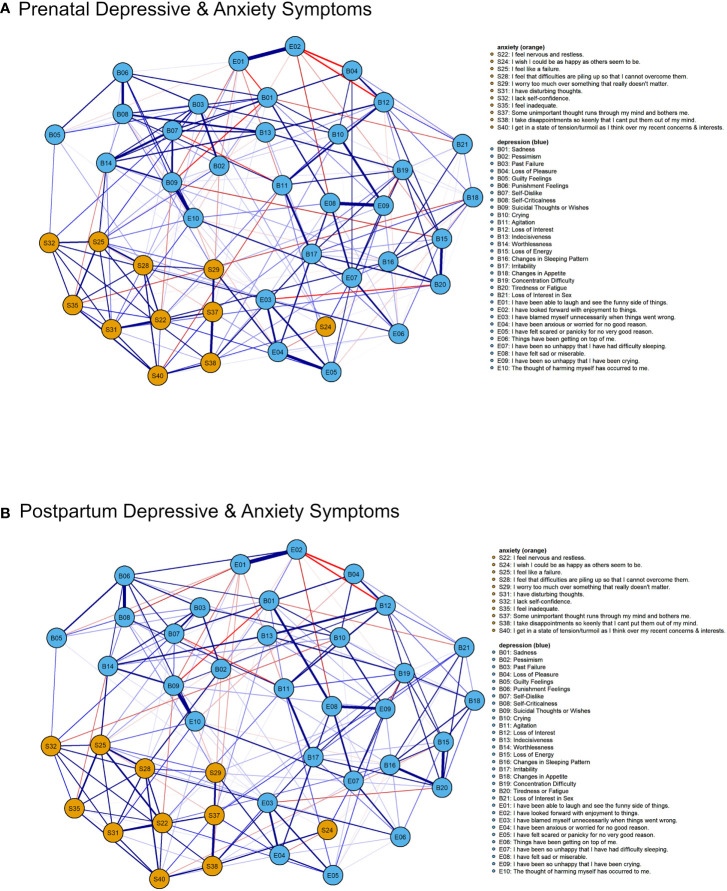
Prenatal (A) and post-partum (B) depressive-anxiety symptoms networks (jointly estimated). Weak edges with weights less than 0.05 are not shown. Blue edge represents positive association between the pair of symptoms (or nodes). Red edge represents negative association between the symptoms. The thickness of the edge represents the strength of association.